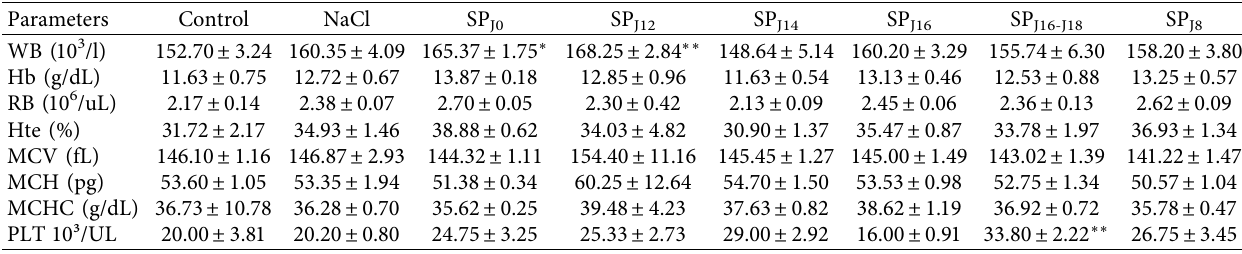
Table 3: Effect of sulfadoxine-pyrimethamine combination on hematological parameters of chicks.